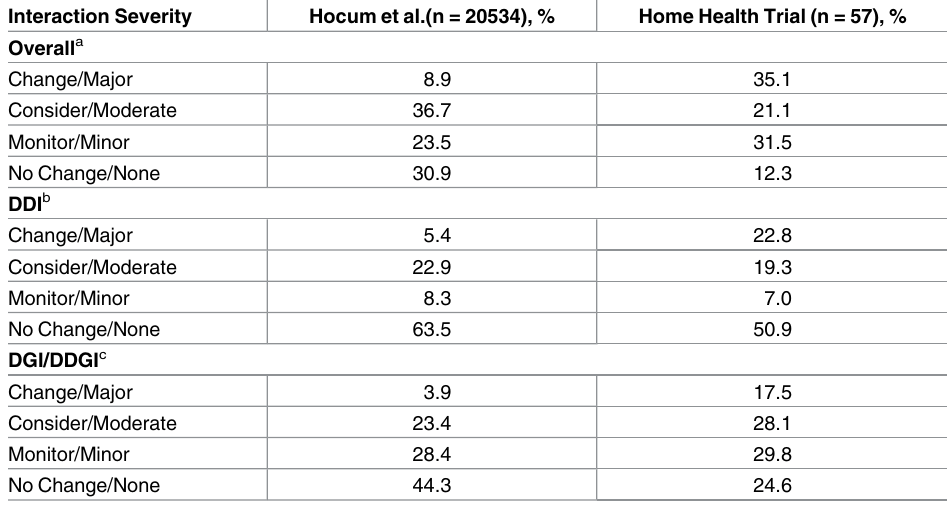
a Most severe drug-drug, drug-gene, or drug-drug-gene interaction detected for each patient b Most severe drug-drug (binary and cumulative) interaction detected for each patient c Most severe drug-gene or drug-drug-gene interaction detected for each